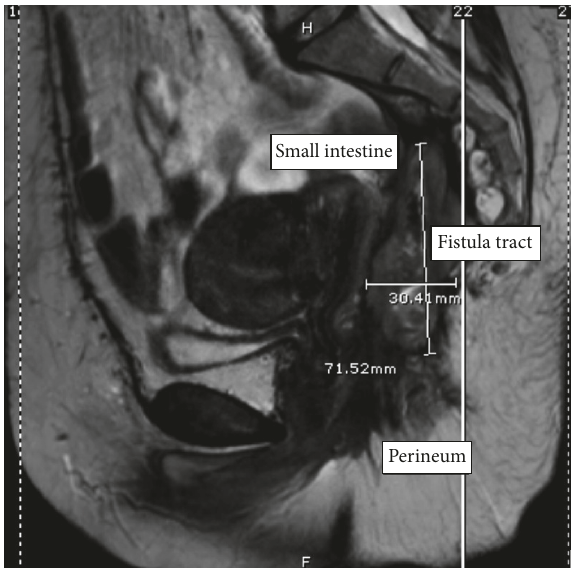
Figure 2: Fistulogram showing passage of contrast through the fistula on the left portion of the image to the small bowel on the right